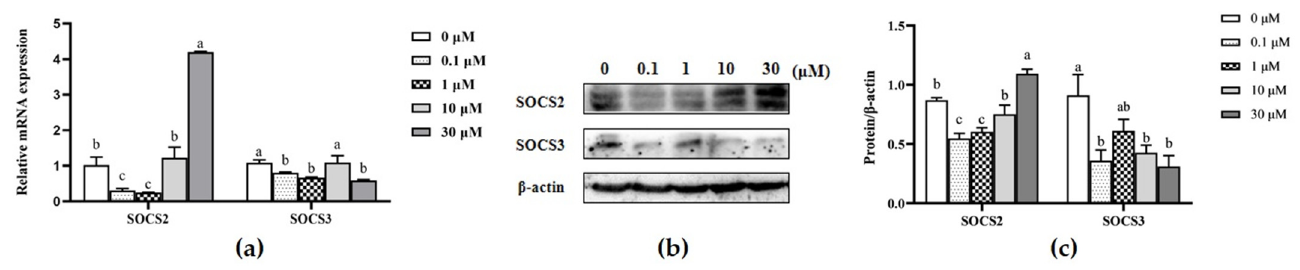
Figure 6. Effects of β -sitosterol on the expression levels of SOCS in MAC-T cells. ( a ) mRNA expression of SOCS2 and SOCS3 genes determined by qPCR. ( b ) Levels of SOCS2 and SOCS3 proteins detected by Western blotting. ( c ) The ratio of SOCS2 and SOCS3 proteins to β -actin control. Data are mean ± SEM ( n = 3). Different lower-case letters indicate significant differences compared to the control ( p < 0.05).